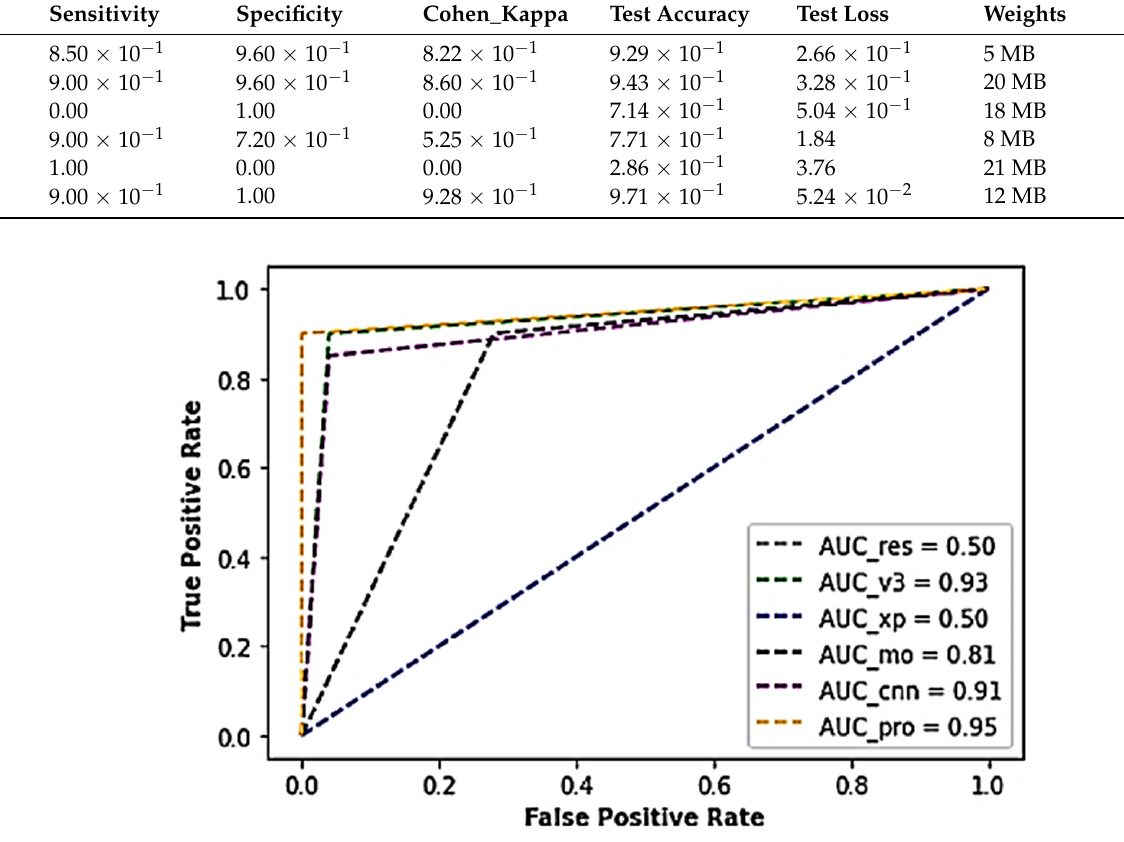
Figure 2. A cross-section of the AUC-ROC results of the industrial AC Piston dataset.